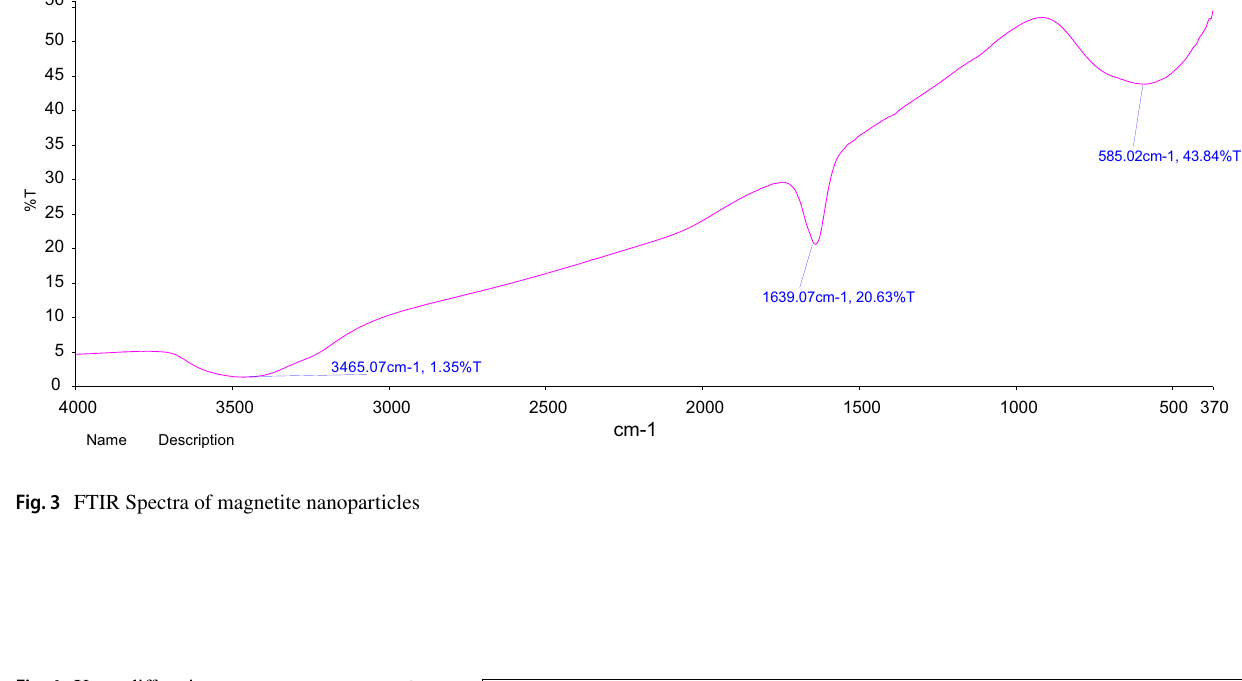
Fig. 4 X-ray diffraction spectra of magnetite nanoparticles